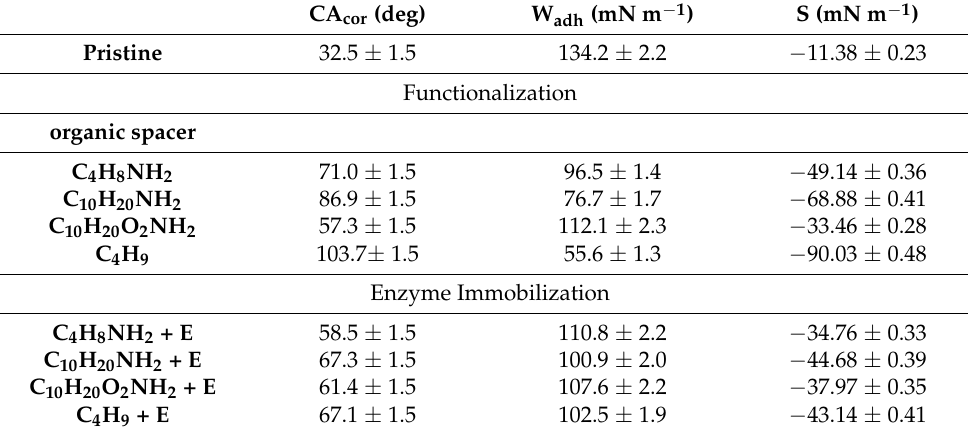
Table 2. Wettability study of the investigated samples.